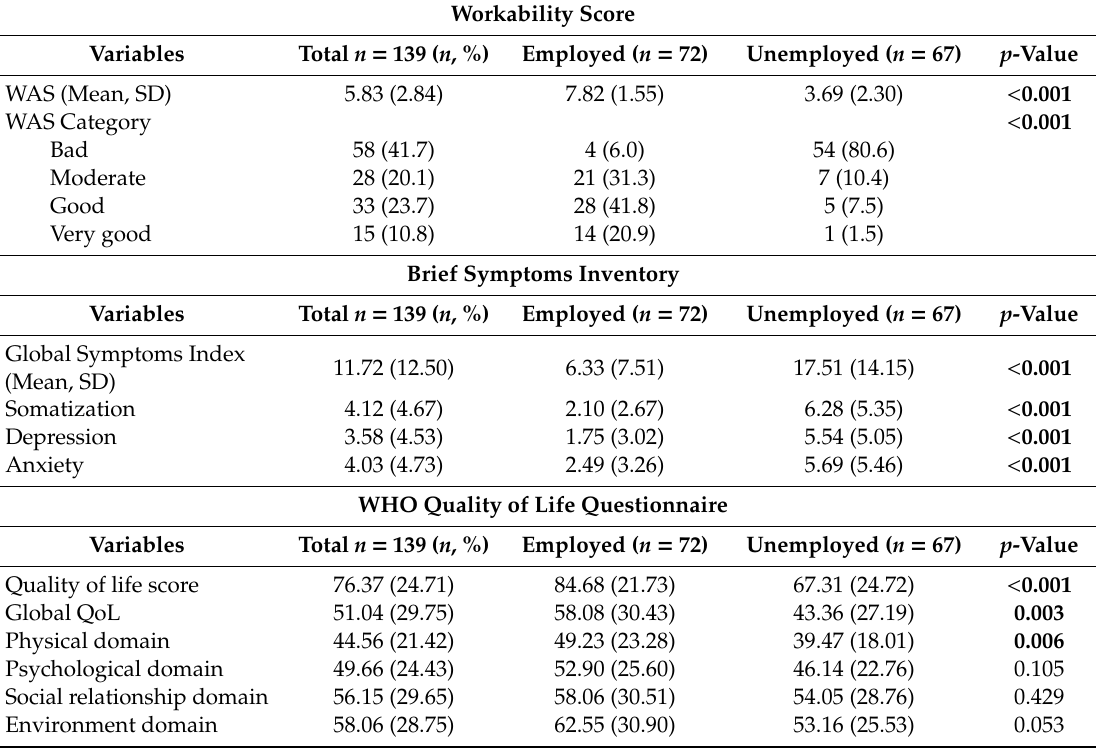
Table 3. Workability, quality of life, mental health symptoms and employment status. Descriptive analysis of Work Ability Index (only currently employed), Brief Symptoms Inventory for mental health issues and quality of life scores as measured by the World Health Organization’s Quality of Life